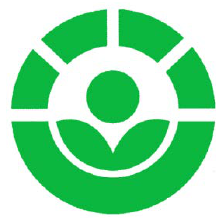
Figure 1. The RADURA symbol.